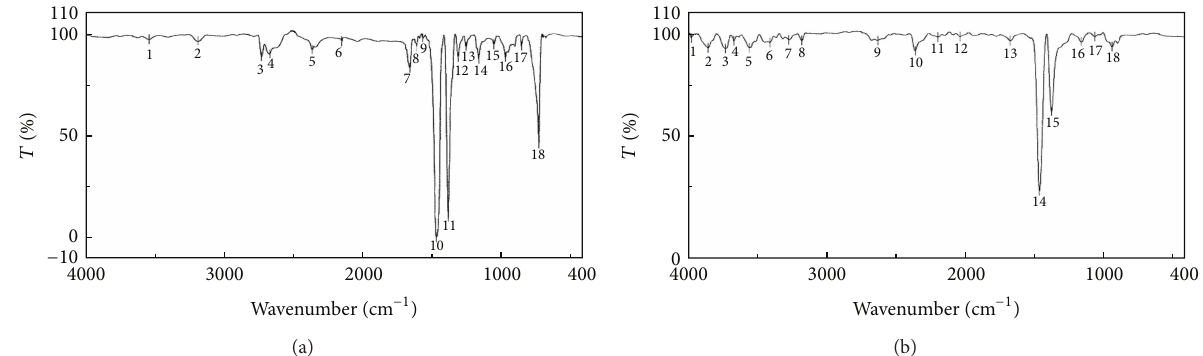
Figure 6: IR spectra of (a) INIMH and (b) scratched MS surface adsorbed INIMH film.